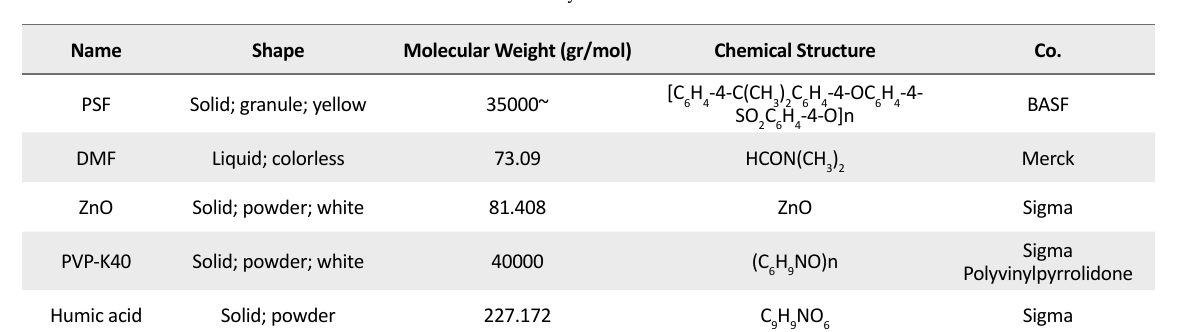
Table 2. Properties of the synthesized membranes using the phase inversion Membrane